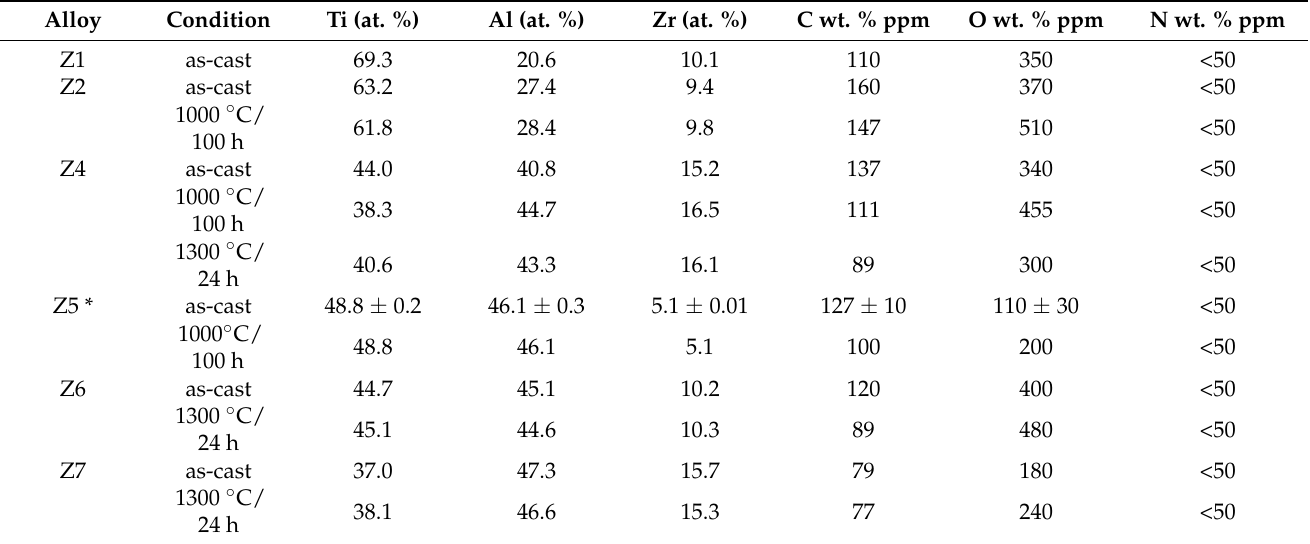
Table 2. Wet-chemical analyses of the as-cast alloys and after various heat treatments.